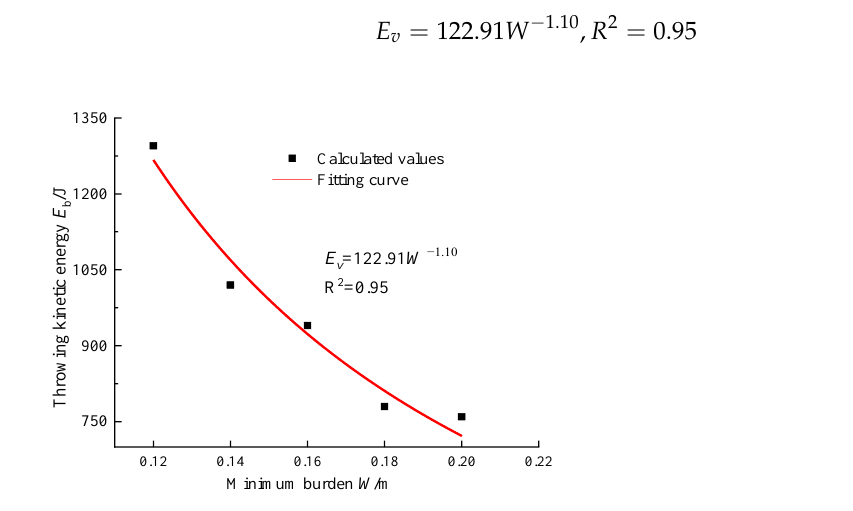
Figure 13. Relation of the thrown kinetic energy with the minimum burden.